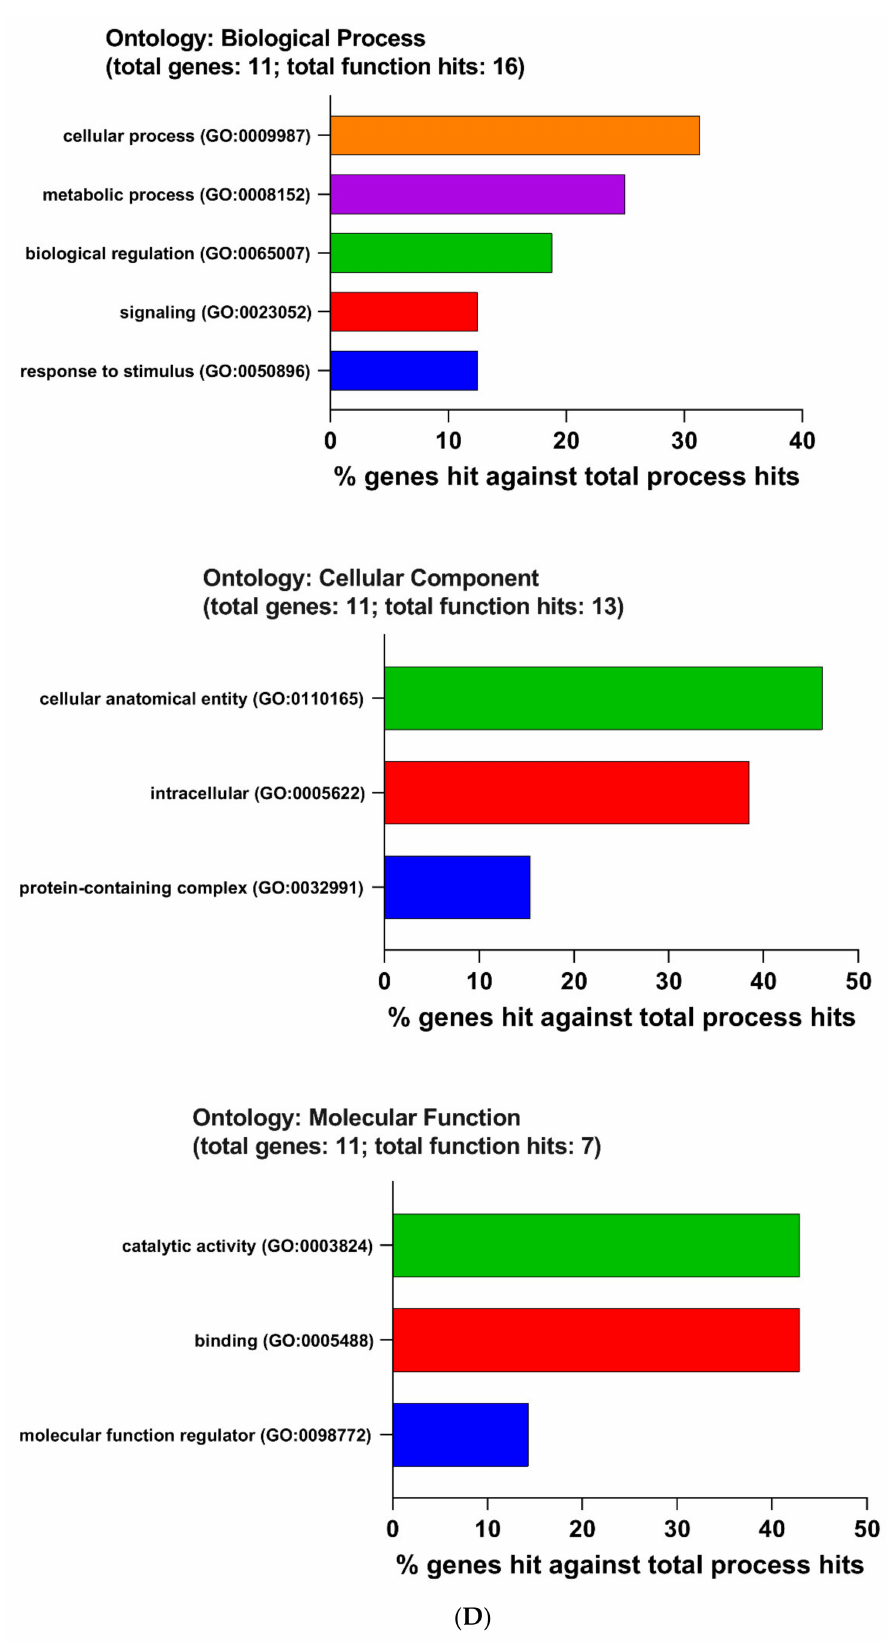
Figure 6. The enrichment analysis results of DEGs by using PANTHER. ( A , B ) Bar plot of enriched biological pathways for down-regulated ( A ) and up-regulated DEGs ( B ) in group 1 (LPS vs. Control). ( C , D ) Bar plot of enriched biological pathways for down-regulated ( C ) and up-regulated DEGs ( D ) in group 2 (TAK vs.